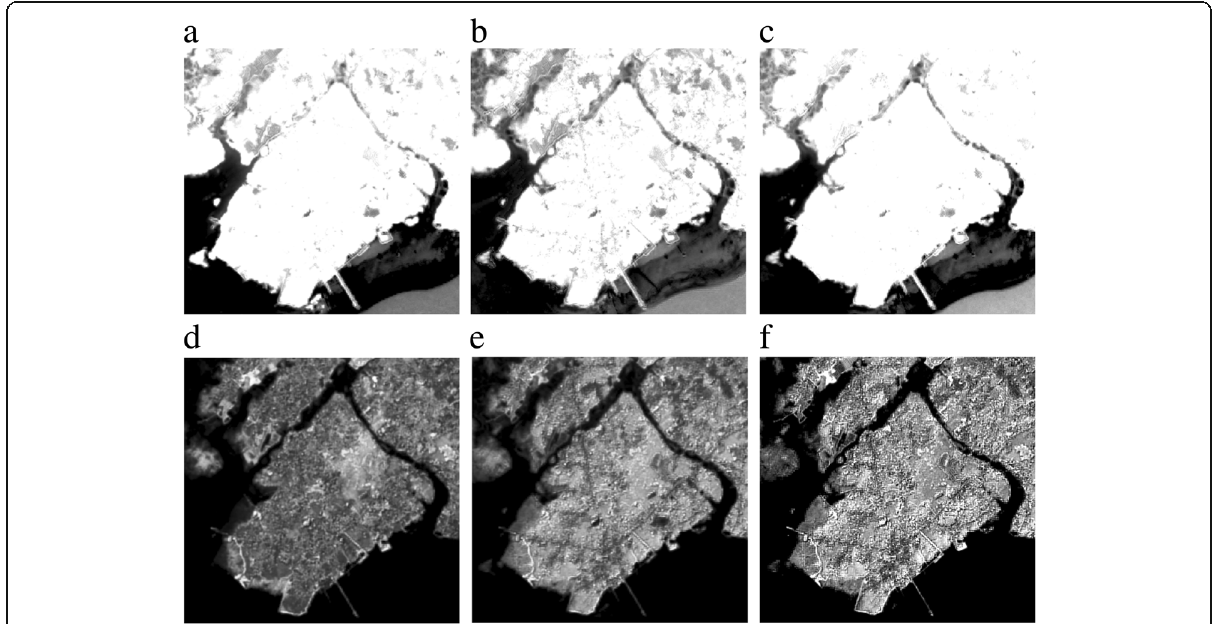
Fig. 8 Images produced by different Water Indexes using Landsat 8 OLI. Contrast enhancement was stretched to one standard deviation both sides. ( a ) NDWI of McFeeters [13], ( b ) NDWI of Rogers and Kearney [14], ( c ) MNDWI of Xu [15], ( d ) AWEI nsh of Feyisa et al. [16], ( e ) AWEI sh of Feyisa et al. [16], ( f ) NIR band. White to black for all multi-band water indexes ( a to e ) is low to high index values as pixels with values greater than their respective threshold values are water bodies. White to black for NIR band ( f ) is high to low index values as pixels of NIR band with values less than its threshold value are water